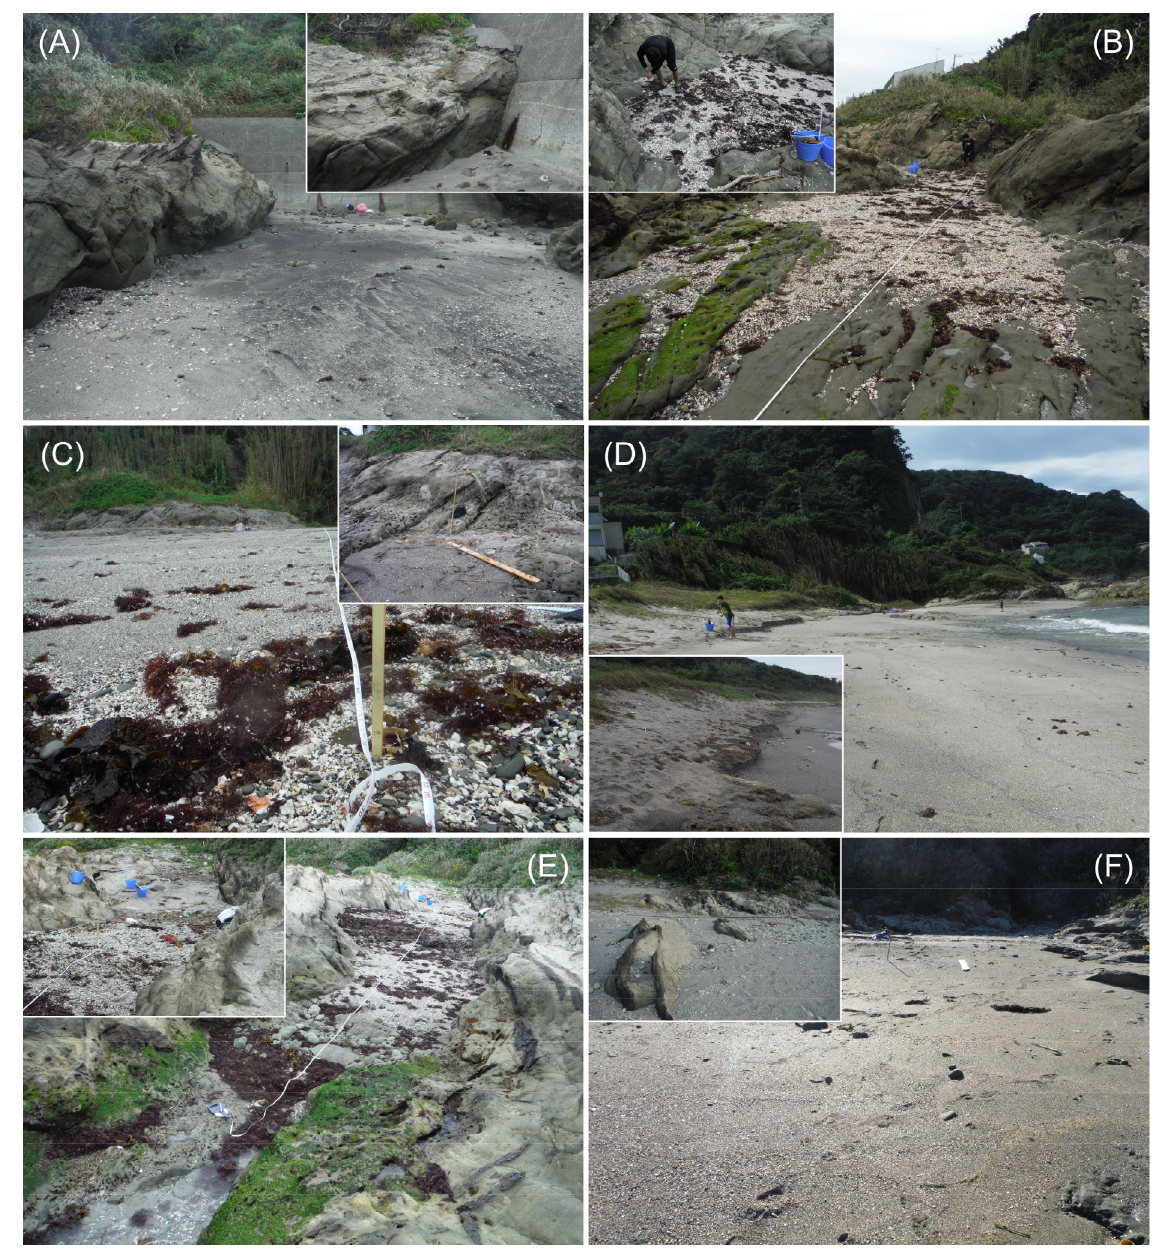
Figure 2. Photographs of the intertidal zones at survey points P1 (A), P2 (B), P3 (C), P4 (D), P5 (E), and P6 (F). The supratidal zone at which the visual search for early juveniles of land hermit crabs was conducted is superimposed on each survey point